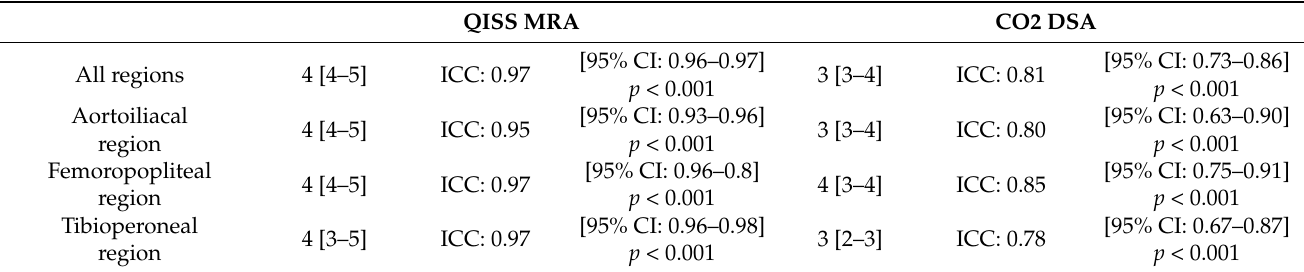
Table 2. Per-region assessment of subjective image quality and reproducibility for stenosis grading of CO2 DSA compared to QISS MRA. Values are expressed as median with interquartile ranges in brackets. CO2 DSA, carbon dioxide digital subtractive angiography. (CO2 DSA: carbon dioxide subtraction angiography, QISS MRA: quiescent-interval single-shot magnetic resonance angiography, ICC: intraclass correlation coefficient, CI: confidence interval).